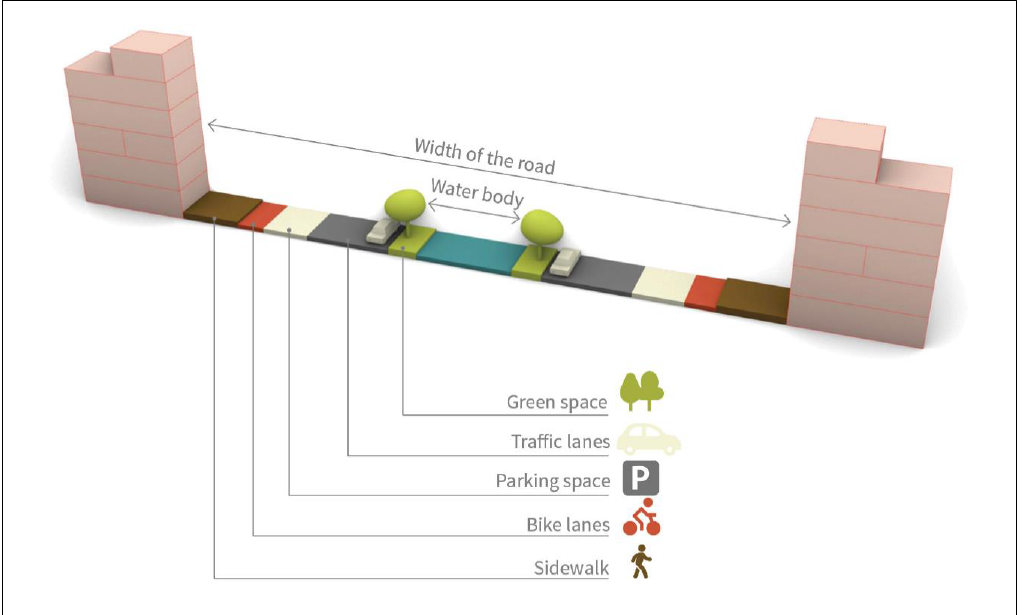
Figure 18. ( Left ) In red: intersections considered as car traffic space. ( Right ) In orange, green, and blue are the effective space for calculations. The color indicates the typology of the roads.